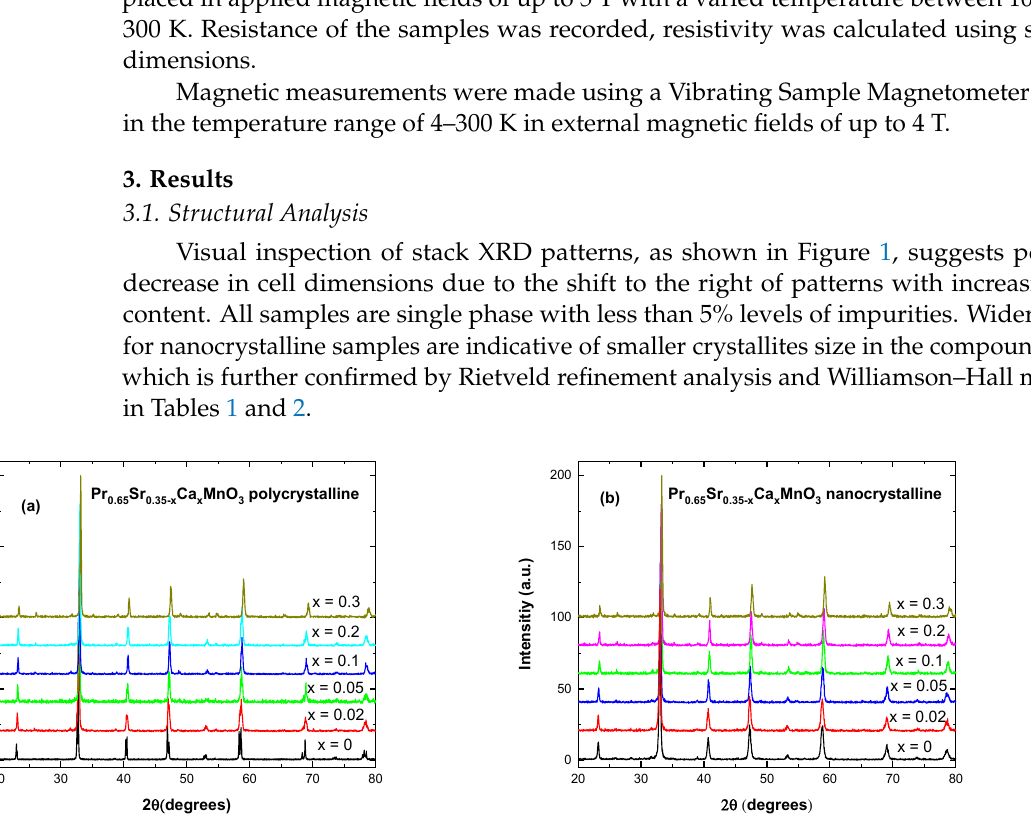
Figure 1. X-ray diffraction patterns for ( a ) Pr 0.65 Sr 0.35 − x Ca x MnO 3 polycrystalline bulk samples and ( b ) Pr 0.65 Sr 0.35 − x Ca x MnO 3 nano-sized samples. Table 1. Calculated tolerance factors, Mn-O lengths, and crystallite sizes for polycrystalline sam- ples using the Williamson–Hall and Rietveld methods and including particle diameters by optical